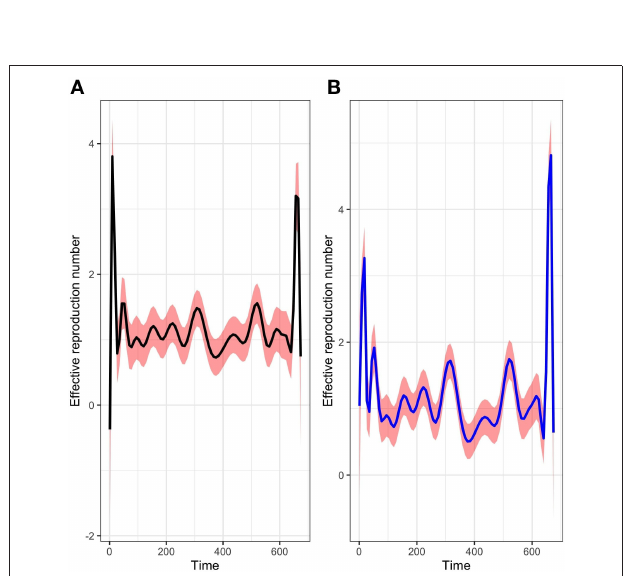
FIGURE 6 | Evolution of the time varying reproductive number in Mayotte from 13 March 2020 to 11 January 2022 with a mixture of Log-normal distribution fit of the serial interval (A) and a mixture of Weibull distribution fit of the serial interval (B) .